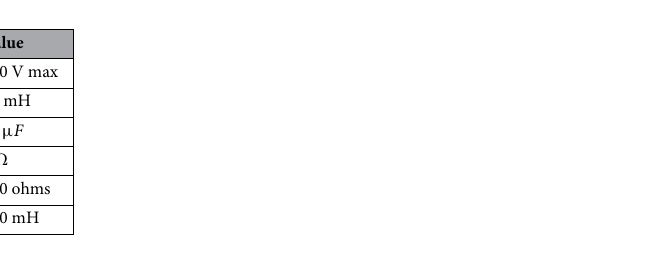
Table 3. Converter